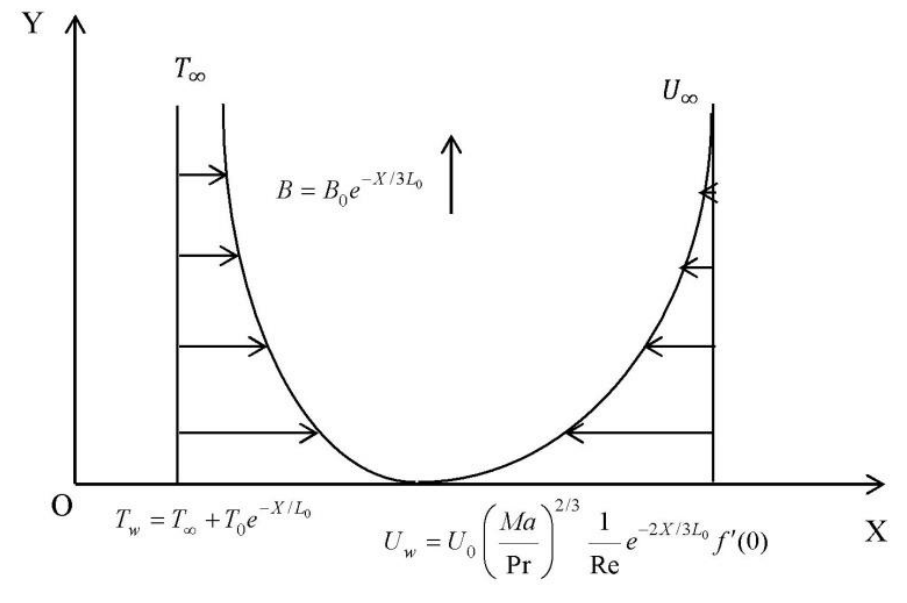
Figure 1. Geometry of the problem under consideration